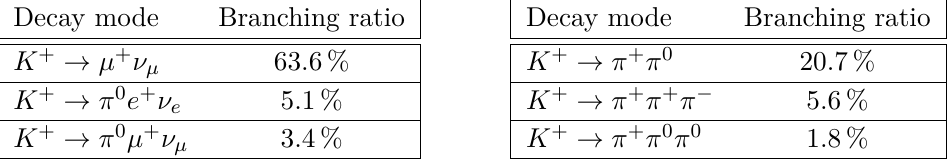
Table 5 . Main leptonic and semileptonic (left) and hadronic (right) K + decay modes and branching ratios